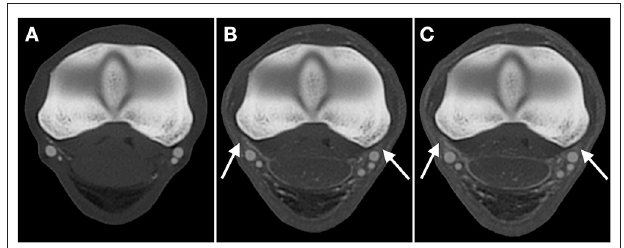
FIGURE 4 | Transverse CT images in a bone algorithm (WW/WL: 800/2,000), showing the comparison of extravasation in the (A) arterial, (B) venous, and (C) arterial-venous combined dynamic phase scans obtained of limb 2, the limb which underwent two freezing-thawing cycles, at the level of the metacarpophalangeal joint (level B). While progressive increased extravasation in this limb is evident (arrows; B, C), decreasing the subjective quality of the scans, the degree of extravasation with lipophilic contrast remains clearly lower when compared to the limb perfused with hydrosoluble contrast in Figure 2 . Top of the image is dorsal, left is